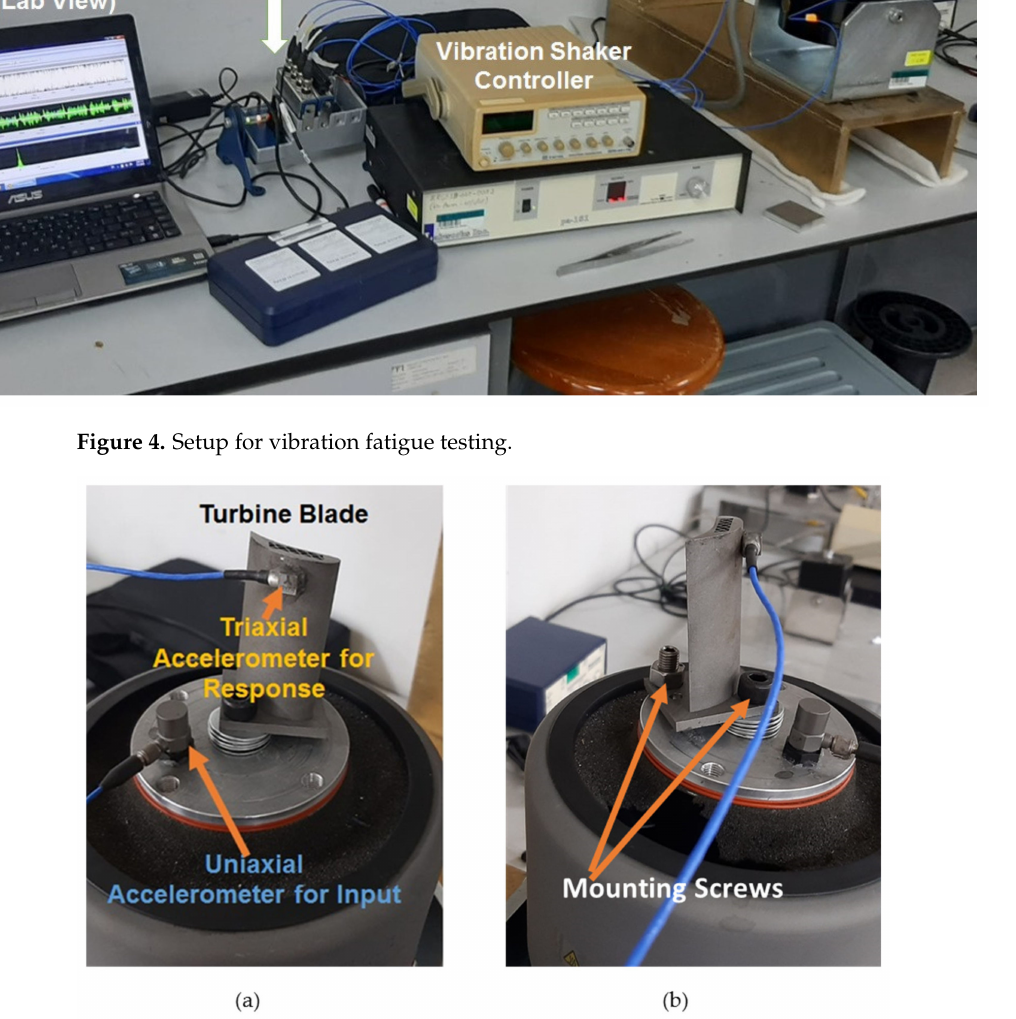
Figure 5. Blade mounting on the vibration shaker: ( a ) accelerometer mounting; ( b ) illustration of mounting